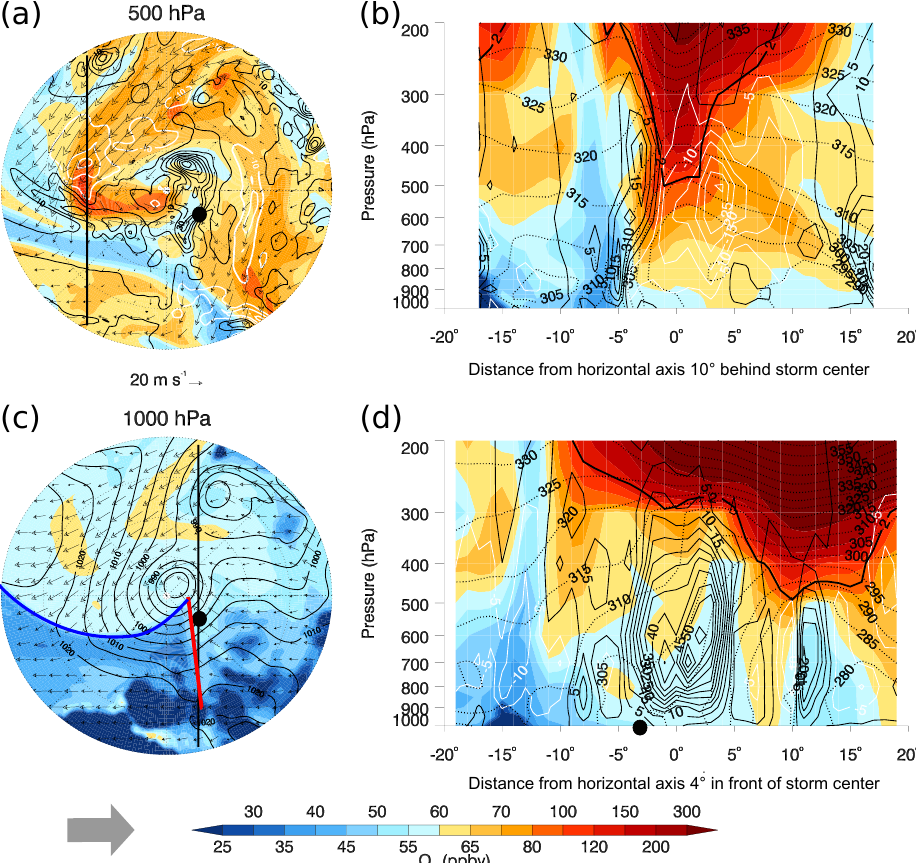
Figure 6. N1 cyclone-centered O 3 (color) and system relative winds (20ms − 1 , reference arrow) on 4 March 2007 at 00:00UTC: (a) 500hPa with ω (10hPah − 1 contour intervals, with black contours for positive values indicating ascent and white contours for negative values indicating descent) and (c) 1000hPa with MSLP (solid black contours, 5hPa contour intervals) and approximate location of the warm (red line) and cold (blue line) fronts based on Figs. 3b and 5a. The cyclone has been rotated in order that the direction of cyclone propagation is toward the right, indicated by the grey arrow. The additional thick vertical lines in (a) and (c) indicate the location of the vertical transects ( b and d ) of O 3 (color), ω (5hPah − 1 contour intervals, with black contours for positive values indicating ascent and white contours for negative values indicating descent), θ e (dotted contour lines, 5K intervals), and the 2PVU isosurface for the dynamical tropopause (thick solid contour): (b) 10 ◦ behind the cyclone center and (d) 4 ◦ ahead of cyclone center, respectively. The cross sections are < 40 ◦ diameter with positive axis values to the north. The approximate location of Mace Head is indicated by the large black dot ( a , c , d